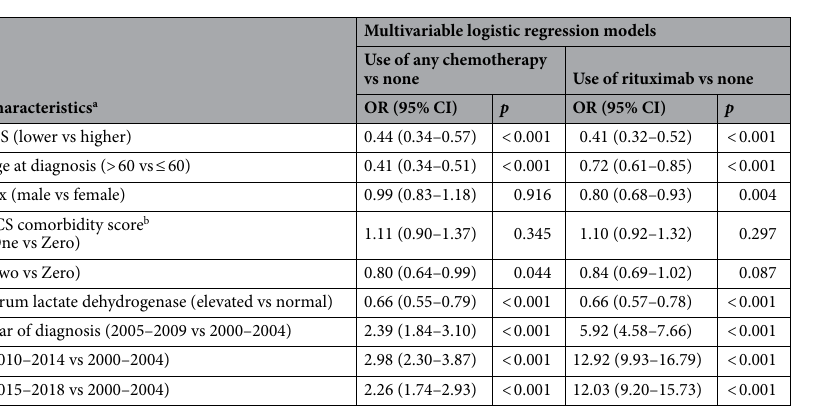
Table 2. Factors for initiation of any chemotherapy and rituximab by multivariable logistic regression models among patients with diffuse large B-cell lymphoma, Hong Kong, 2000–2018 (N = 4017). CI confidence intervals, OR odds ratio, RCS Royal College of Surgeons, SES socioeconomic status. a Adjusted for all the covariates included in Table 1 except race, because most of the patients were Hong Kong Chinese. b Included myocardial infarction, congestive heart failure, peripheral vascular disease, cerebrovascular disease, diabetes mellitus, dementia, chronic pulmonary disease, rheumatic disease, liver disease, hemiplegia/paraplegia, renal disease, acquired immune deficiency syndrome/human immunodeficiency viral